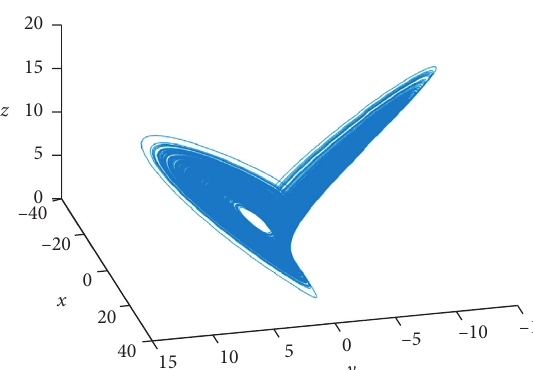
Figure 9: Dynamics of Lu et al.’s fractional-order system in (13)–(15) with the order α � 0 . 88, in context of x , y , and z directions.